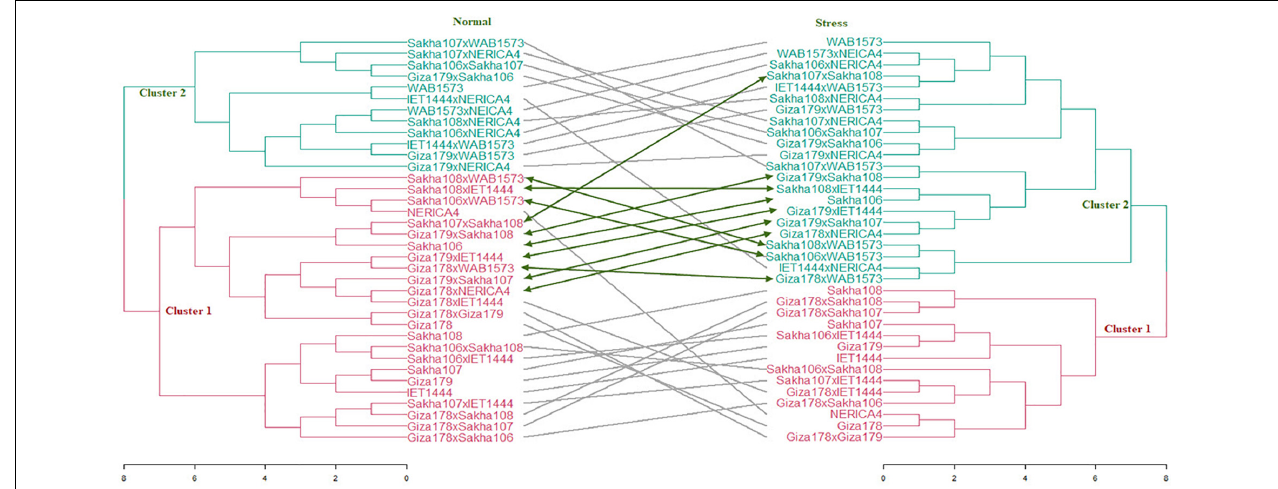
FIGURE 3 | A tangle-gram showing results of cluster analysis based on Euclidean coefficient and Ward method under normal and water stress conditions.